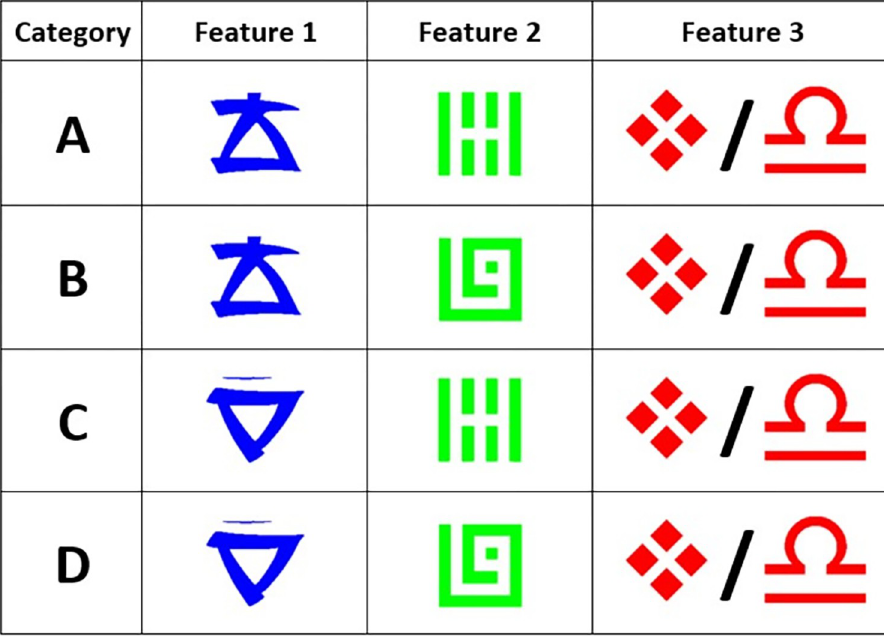
Fig 1. Example stimulus features and category structure. Each of the four categories can be uniquely determined from the value of features 1 and 2, while feature 3 has no bearing on the category. Optimal information sampling is thus viewing features 1 and 2, and ignoring feature